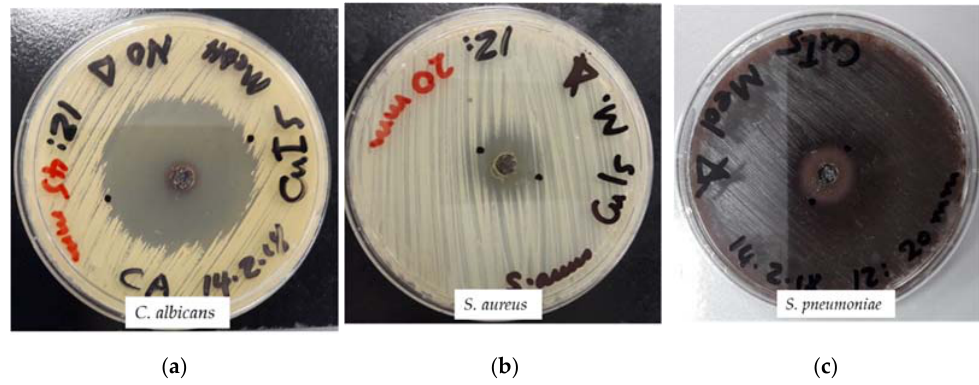
Figure 10. The Agar Well (AW) analysis of the title compound (with concentrations of 11, 5.5, and 2.75 μ g/mL). From left to right: ( a ) C. albicans WDCM 00054; ( b ) S. aureus ATCC 25932 ; and ( c ) S. pneumoniae ATCC 49619.